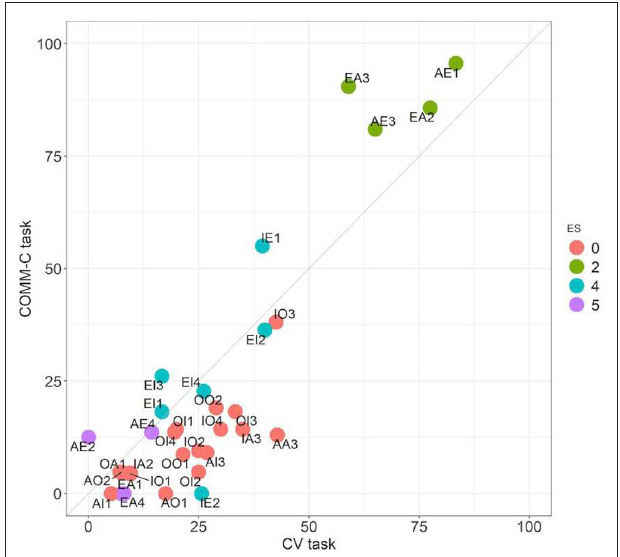
FIGURE 6 | Comparison between the CV and the COMM-C tasks. Performance across the 32 problems. Colors follow the ES